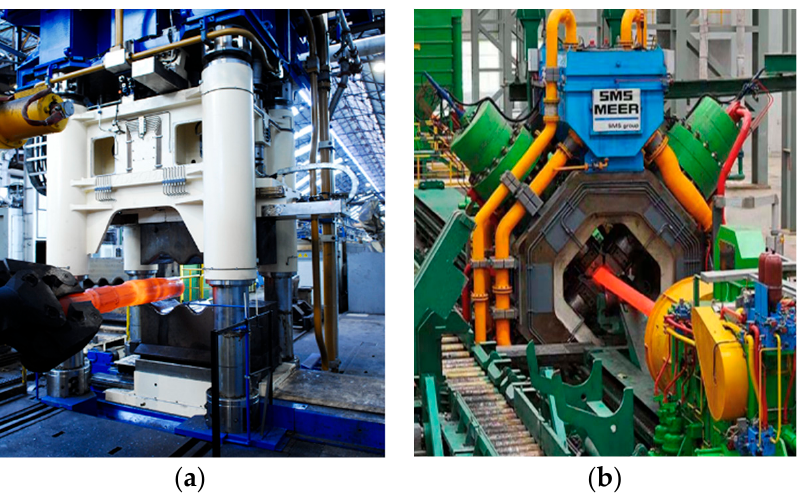
Figure 2. Forging process of hollow axle : ( a ) open-die forging process; ( b ) radial precision forging.